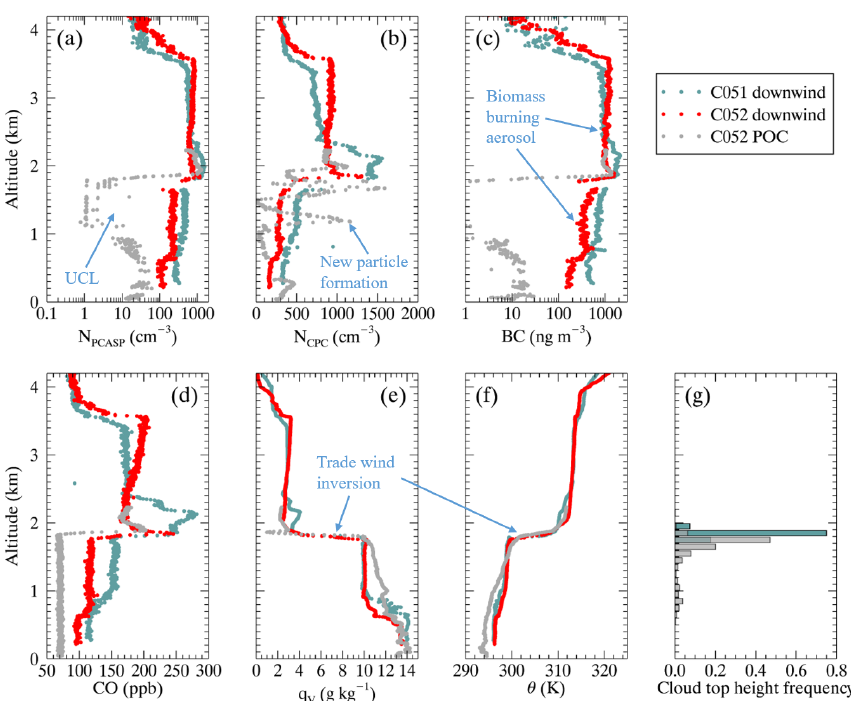
Figure 5. Vertical profiles of PCASP number concentration, CPC number concentration, BC mass concentration, carbon monoxide, water vapour mixing ratio and potential temperature within and downwind of the POC. The frequency of cloud top height as a function of altitude is shown in panel (g) . The cloud top height data are from measurements made from the aircraft lidar when flying above the boundary layer over the POC on flight C052 and over the closed cells downwind of the POC on flight